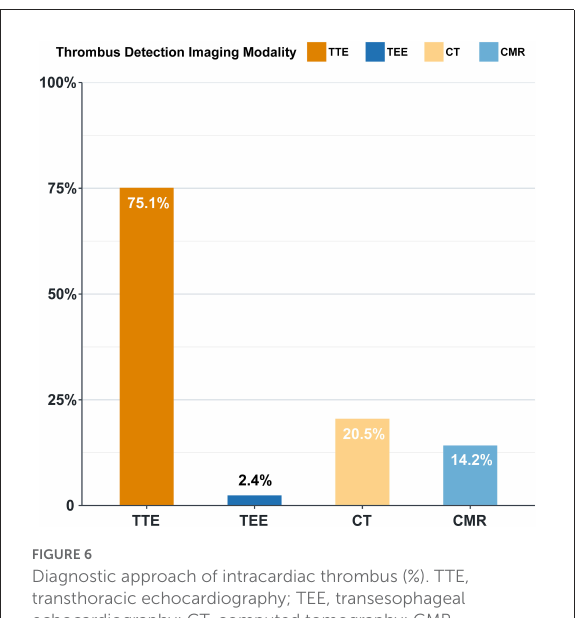
FIGURE6 Diagnostic approach of intracardiac thrombus (%). TTE, transthoracic echocardiography; TEE, transesophageal echocardiography; CT, computed tomography; CMR, cardiovascular magnetic